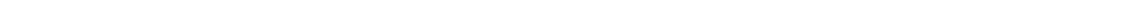
Fig. 5 Prolonged anti-CSF1R treatment impairs crypt homeostasis. Mice were treated with anti-CSF1R mAb or control-IgG (control) for 6 weeks before analysis. A parallel group of mice were allowed to recover for 8 wk following anti-CSF1R mAb treatment. a Comparison of Lgr5 mRNA expression in isolated intestinal crypts from anti-CSF1R (open bars) or control-treated (closed bars) mice by RT – qPCR analysis. Bars represent mean ± SEM derived from four mice/group. * P < 0.05, two-tailed unpaired Student ’ s t -test. b Two-color mRNA in situ hybridization analysis con fi rmed a reduction in Lgr5 mRNA expression (red) at the base of intestinal crypts coincident with the ablation of Csf1r mRNA (blue) expressing macrophages. Representative images from three mice/group are shown. Scale bar, 25 µ m. c Detection of proliferating Ki-67 + cells (red) in intestinal crypts by IHC. Sections counterstained with DAPI to detect nuclei (blue). Broken lines indicate the crypt epithelial cell layer boundary. Scale bar, 20 µ m. d Morphometric analysis of (left) the magnitude of Ki-67-speci fi c immunostaining in intestinal crypts, and (right) the distribution of Ki-67-expression within the crypt. Data represent mean ± SD derived from 5 to 9 sections from four mice/group. *** P < 0.001, two-tailed unpaired Student ’ s t- test. e IHC detection of SOX9 expression (green) in intestinal crypts. Sections were counterstained with DAPI to detect cell nuclei (blue). Scale bar, 50 µ m. f Morphometric analysis con fi rmed that following prolonged CSF1R blockade the % area of the crypts with SOX9 + cell nuclei was signi fi cantly increased. Bars represent mean ± SD derived from four mice/group with 50 – 100 crypts/mouse, and are representative of data from two independent experiments. * P < 0.05, one-way ANOVA with Tukey ’ s post hoc test. g RT – qPCR analysis of Bmi1 mRNA expression in isolated intestinal crypts from anti-CSF1R or control-treated mice. Bars represent mean ± SEM derived from four mice/group. * P < 0.05, two-tailed unpaired Student ’ s t -test. h mRNA in situ hybridization analysis revealed an increase in the abundance of Bmi1 - expressing cells (red, arrows) in the intestinal crypts of anti-CSF1R-treated mice. Scale bar, 20 µ m. i Mean no. Bmi1 -expressing cells/crypt. Bars represent mean ± SD derived from four mice/group with 40 – 50 crypts/mouse. * P < 0.05, one-way ANOVA with Tukey ’ s post hoc